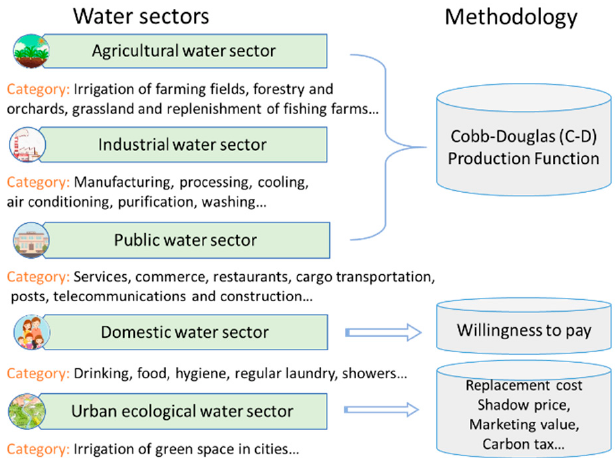
Figure 4. Evaluation framework for estimating the economic value of five water sectors.